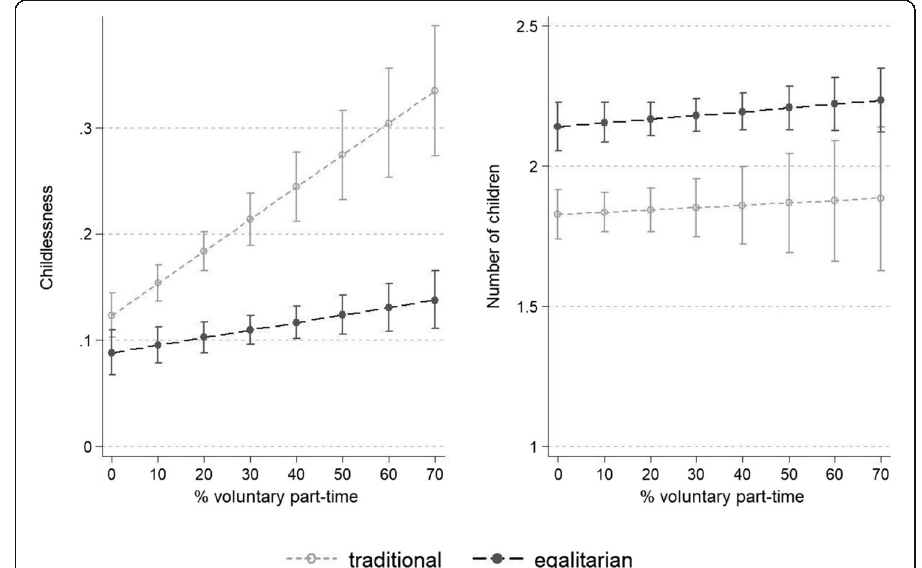
Fig. 5 Predicted probabilities of being without children (left panel) and predicted number of children (right panel) by the share of female part-time and different levels of gender egalitarianism. Source : EU-LFS 2005- 2010, author ’ s elaboration. Note : Predictions refer to Tables 10 and 11 in the Appendix, models C4b and N4b. 90% confidence intervals